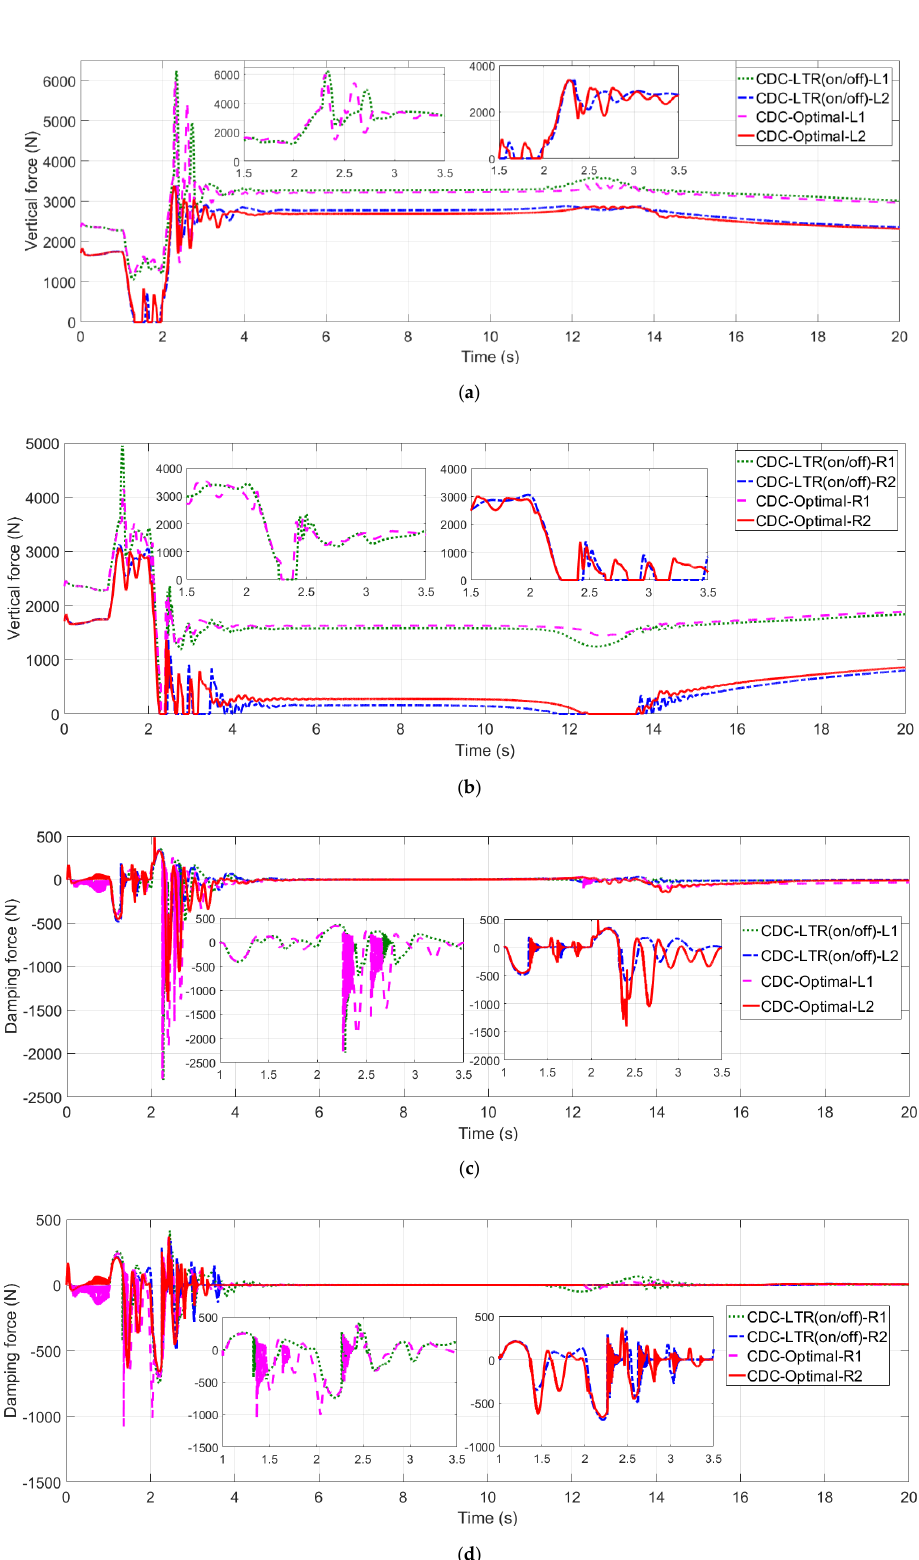
Figure 8. Vertical and damping forces of each wheel in fishhook test with CDC-LTR and CDC-ODDF. The details can be seen in the legend. ( a ) is the comparison result of the vertical forces of wheels on the left. ( b ) is the comparison result of the vertical forces of wheels on the right. ( c ) is the comparison result of the damping forces of wheels on the left. ( d ) is the comparison result of the damping forces of wheels on the right. L is short for left, and R is short for right. Here, 1 represents the front axle, and 2 denotes the rear